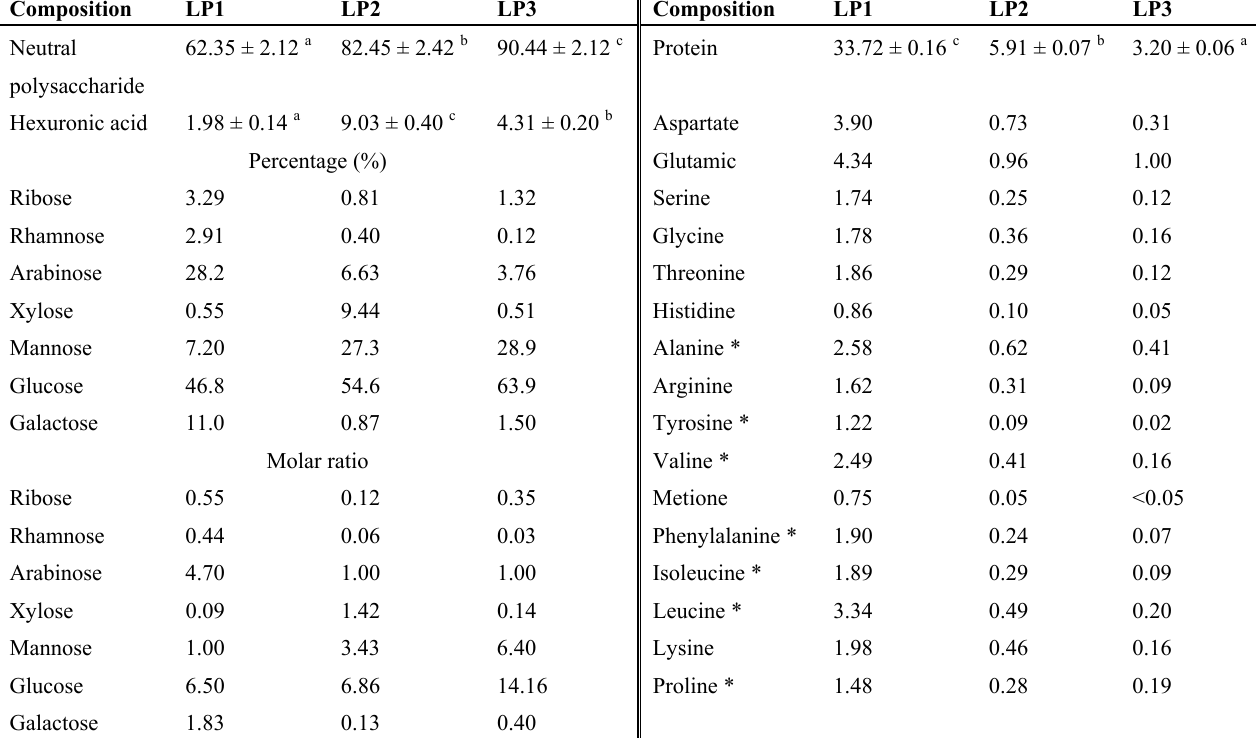
Table 1. Chemical compositions of LP1-3 (g/100